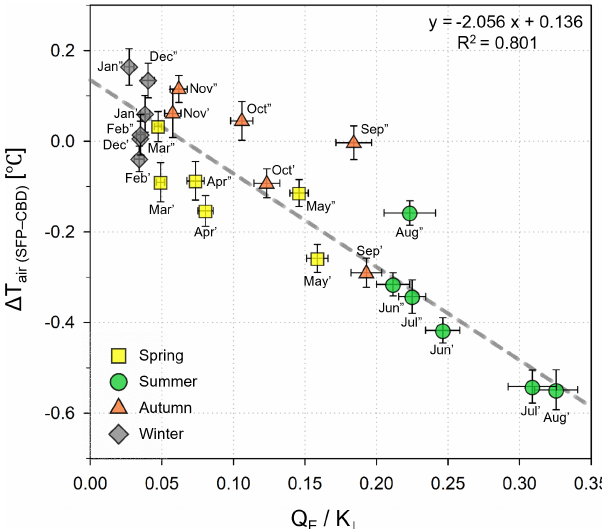
Figure 8. Relationship between the ratio of monthly Q E to K ↓ and mean air temperature difference between SFP and CBD during the daytime ( K ↓ > 120Wm − 2 ) for 2 years. The quotation and double- quotation marks on the scatter indicate the first and second year of the observation period, respectively. The error bars represent stan- dard errors based on daily values, and the gray dotted line is calcu- lated using linear regression model considering errors in both axes (York et al.,